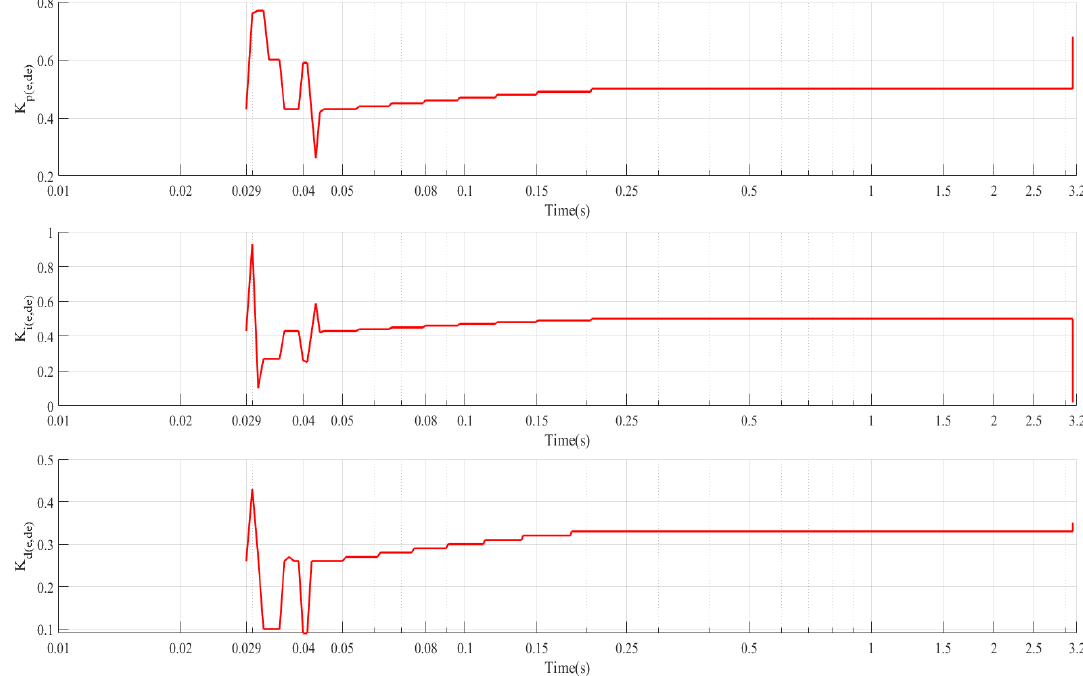
Figure 13. Fuzzy control output parameters: K p ( e ,˙ e ) , K i ( e ,˙ e ) and K d ( e ,˙ e ) with adaptive